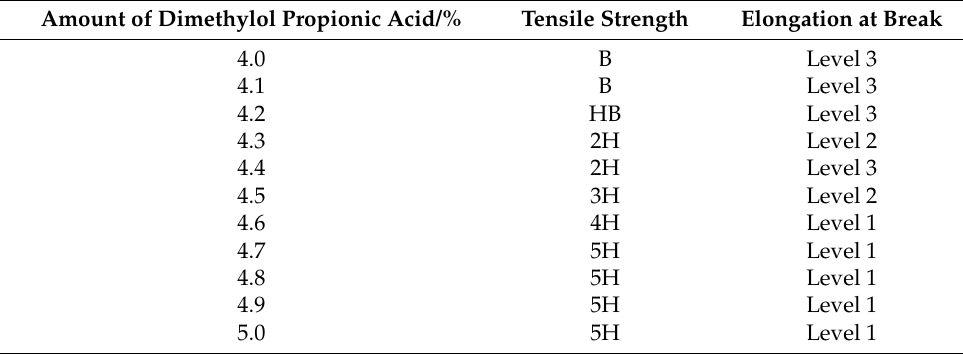
Table 2. Effect of dimethylol propionic acid content on the hardness and adhesion. Amount of Dimethylol Propionic Acid/%